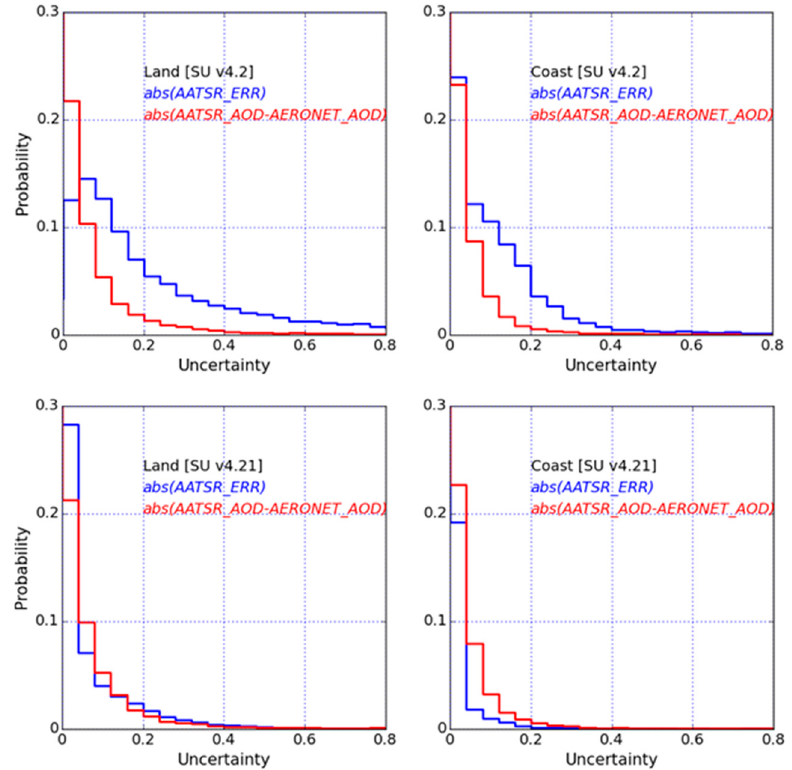
Figure 8. Improvement of histograms of the estimated uncertainty (in blue) compared to the AOD difference to AERONET (in red) for the SU algorithm (10 years AATSR) for two versions (upper: v4.2, lower: v4.21) over land ( left ) and coastal ( right ) sites.